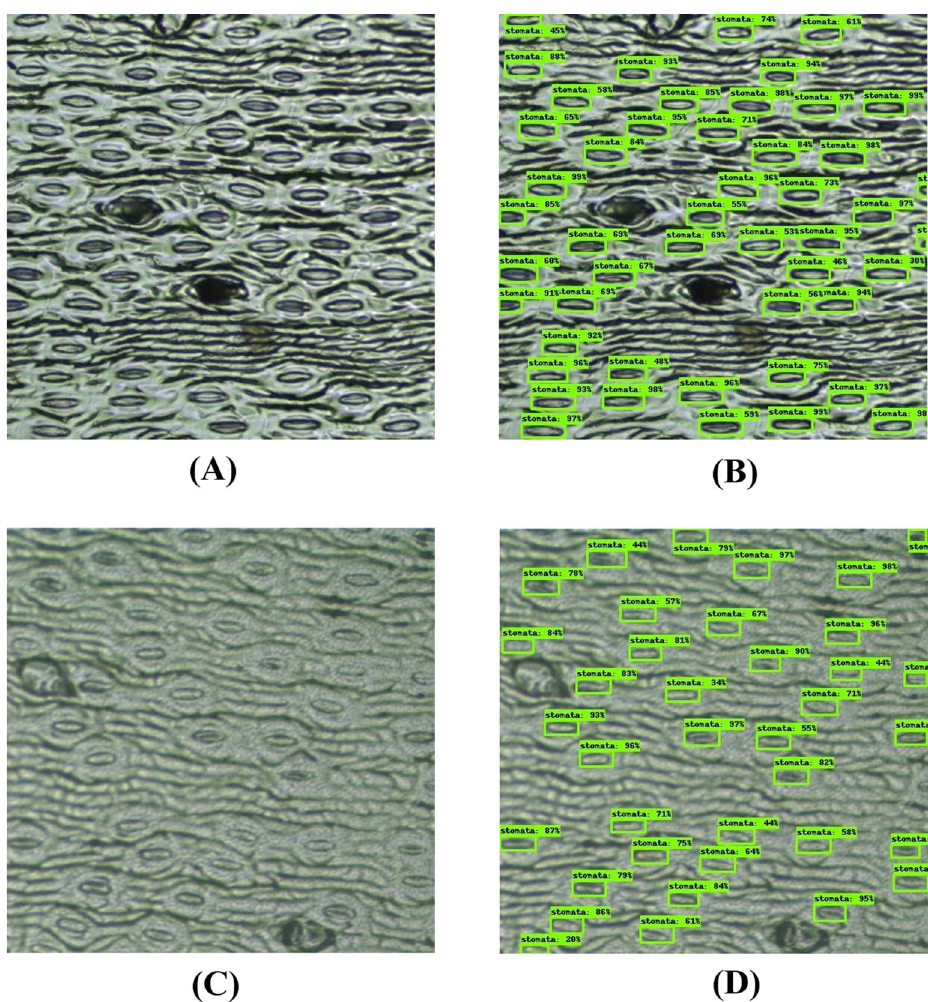
Figure 4. Representative tiles before and after automated detection using developed stomata model. The detected stomata were labelled in green bounding boxes together with a detection score on top. ( A ) Clear tile.